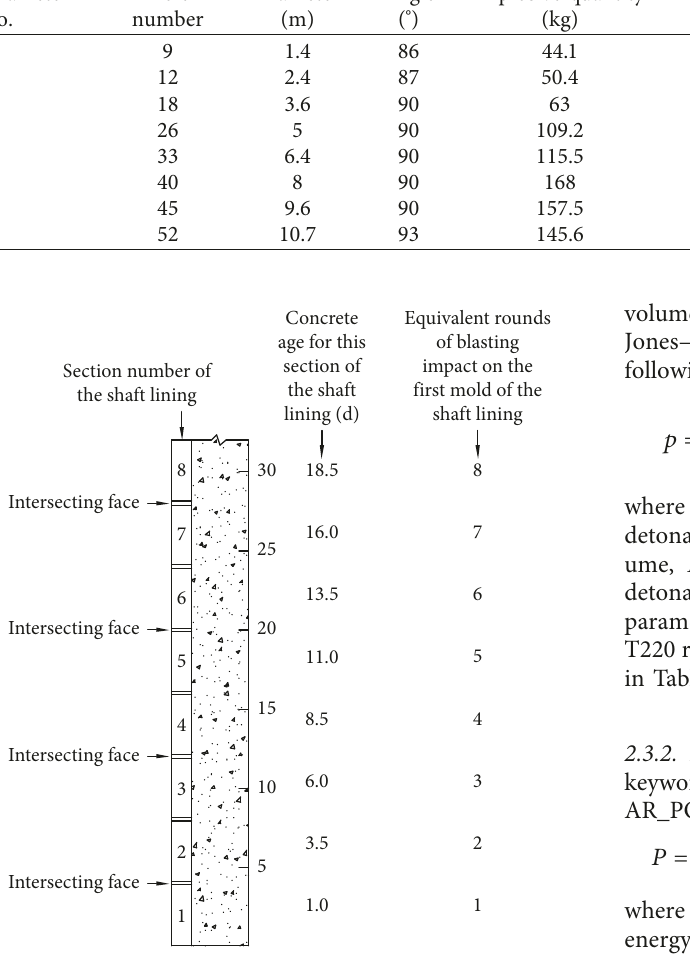
Figure 2: Schematic diagram of the shaft lining